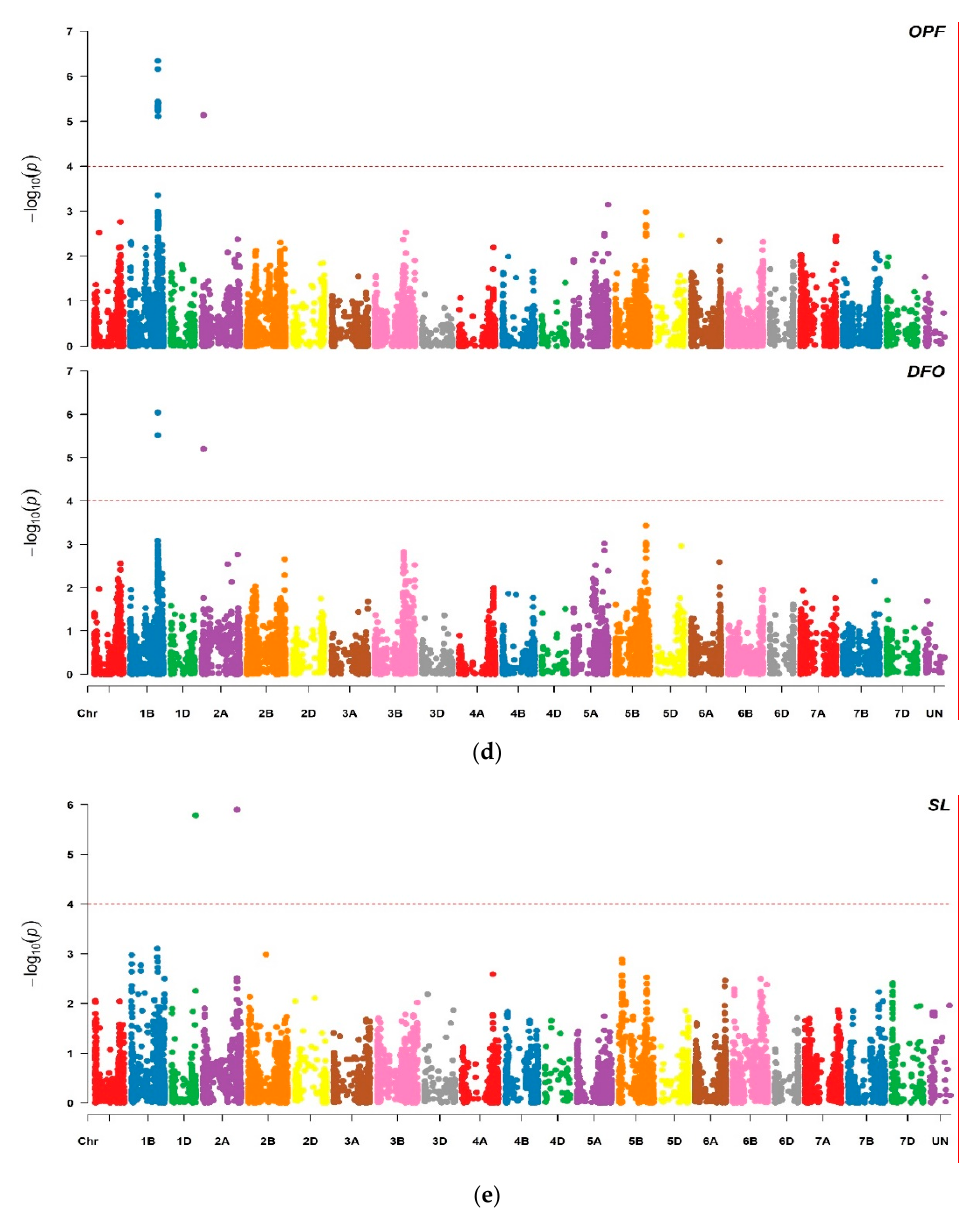
Figure 1. Manhattan plots of genome-wide association analysis for the evaluated floral traits: ( a ) AE and VAE; ( b ) PM and PSH; ( c ) PV and AL; ( d ) OPF and DFO; and ( e ) SL. p values are shown on a − log10 scale and the significant markers are above the threshold FDR ≤ 0.05. Trait abbreviations are given in Tables 1 and 2.